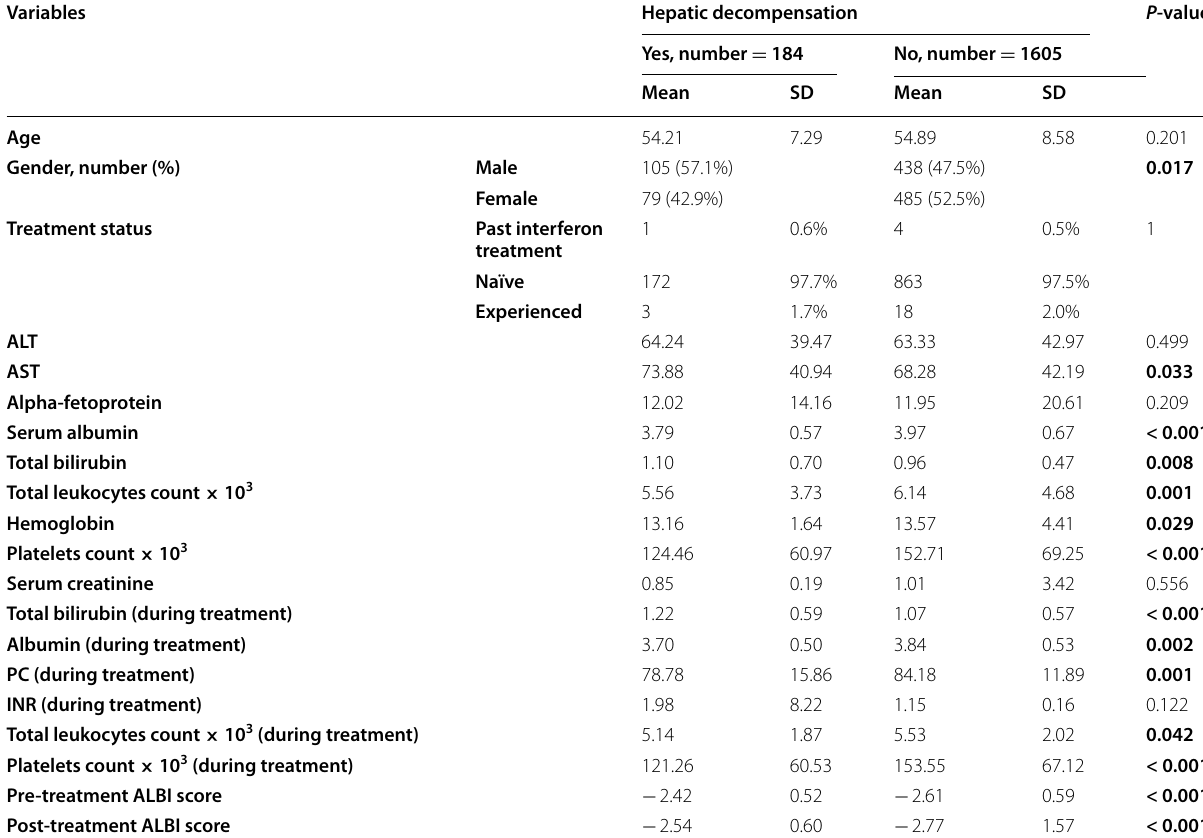
Table 1 Demographic and laboratory features of the studied patients according to the occurrence of hepatic decompensation